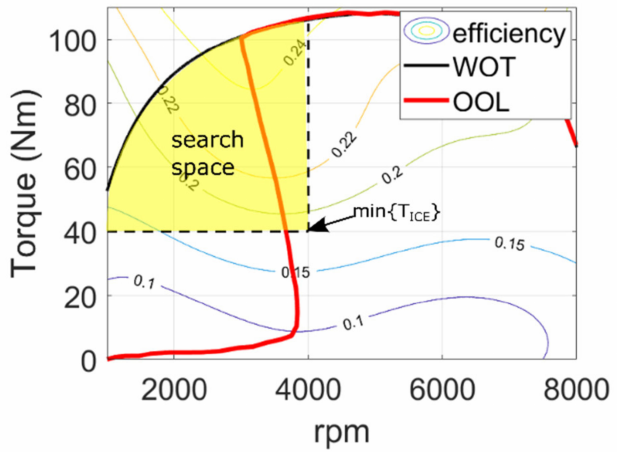
Figure 10. Search space for the selection of the engine working point according to the minimum value of { T ICE }